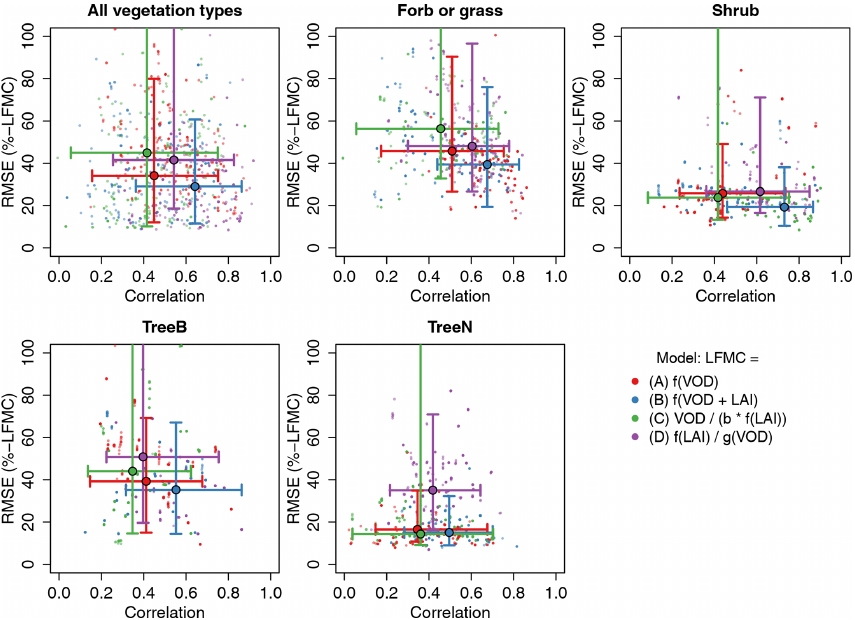
Figure 5. Performance of the models A–D using daily Ku-VOD (and monthly LAI in models C and D) after calibrating each model at each site. Shown is the root mean squared error (RMSE) and correlation coefficient between estimated and measured LFMC. Small dots are results from different parameter sets at each site, and big dots and bars are the median and range from the 5th–95th percentiles across all sites,